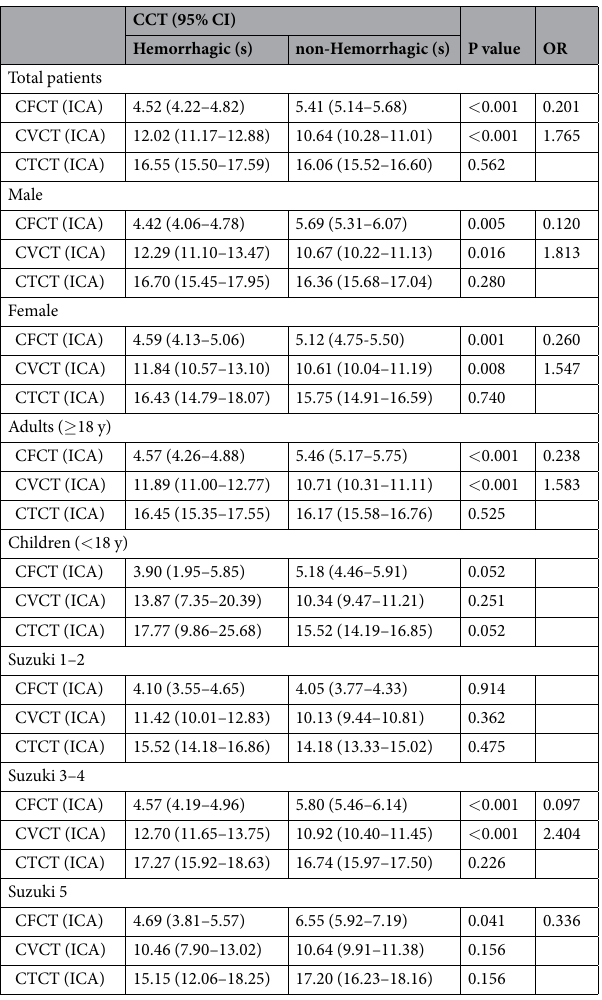
Table 1. CCT of Hemorrhagic and non-Hemorrhagic Hemisphere in Different Demographic Groups. Logistic regression (multivariate analysis) was used to analyze the differences of cerebral circulation time between hemorrhagic and non-hemorrhagic MMD in different demographic